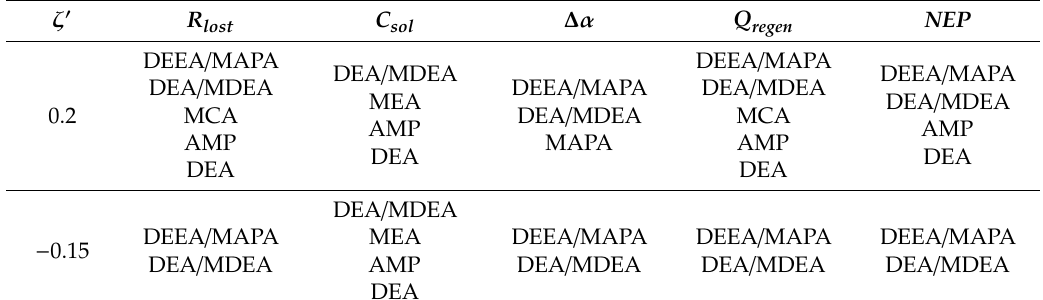
Table 8. Mixtures presenting the optimal trade-o ff between performance and sensitivity at ζ (cid:48) = 0.2 and ζ (cid:48) = −